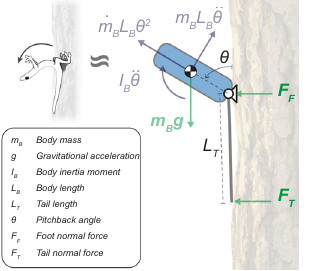
Fig. 3 Free body diagram depicts forces acting on the system during the peak excursion phase of the fall-arresting response. Body position θ corresponds to the pitch-back angle that is enclosed by the geckos ’ torso and the tree trunk. External forces are indicated in green, bold font, whereas virtual forces are shown in collided with the tree trunk at high-impact speeds over 6 m/s. A possible explanation for the use of the tails is that the limits of foot adhesive forces required to maintain contact would otherwise be exceeded as has been suggested for some substrates 35,36 .